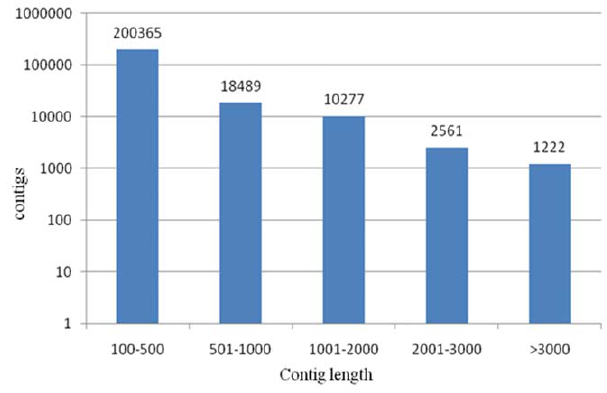
Figure 1. Distribution of number of read per contig in both libraries. The number of contigs presenting the indicated amount of reads is plotted as histogram.